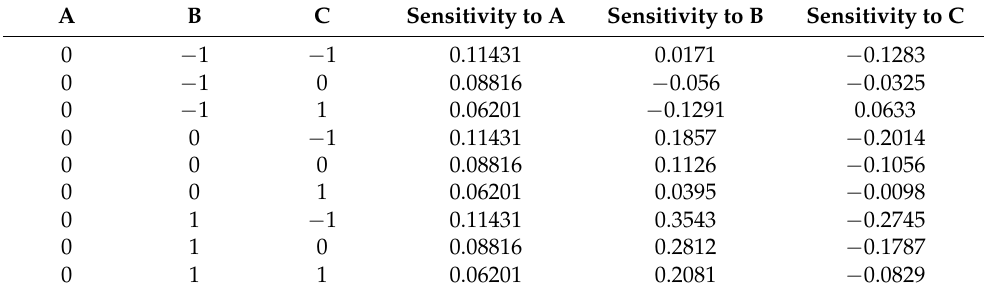
Table 7. Sensitivity analysis of the response Cf x .